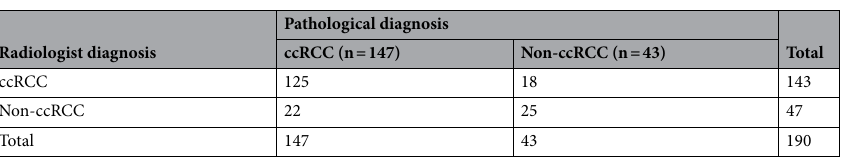
Table 3. Radiologist diagnosis of ccRCC and non-ccRCC compared with pathological findings (n = 190). ccRCC clear cell renal